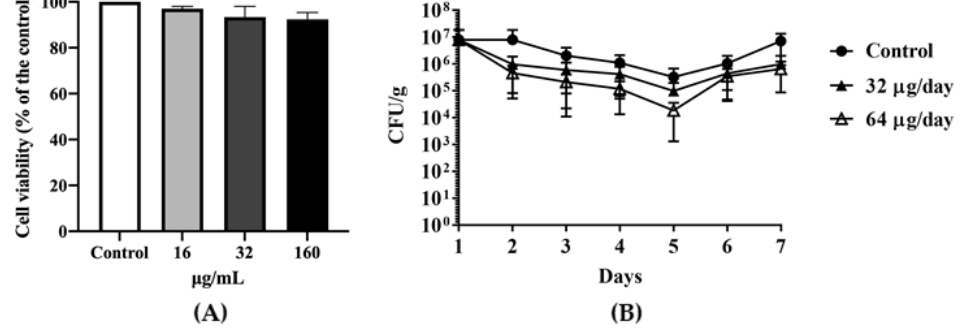
Figure 3. The in vivo antimicrobial effect of DATS. ( A ) the MTT((3-(4,5-Dimethylthiazol-2-yl)-2,5- diphenyltetrazolium bromide)) assay of Hela cell under a serial of DATS treatments. ( B ) C. jejuni 81-176 colonization by colony-forming unit (CFU) per gram of cloacal samples in Hy-line variety white chickens during seven-day DATS treatment. The dark circle represented the control group treated with PBS; the dark up-pointing triangle represented the group treated with 32 μ g DATS per day; the white up-pointing triangle represented the group treated with 64 μ g DATS per day. Each group contained five chickens. CFU data indicated an average of three animals with a standard deviation.